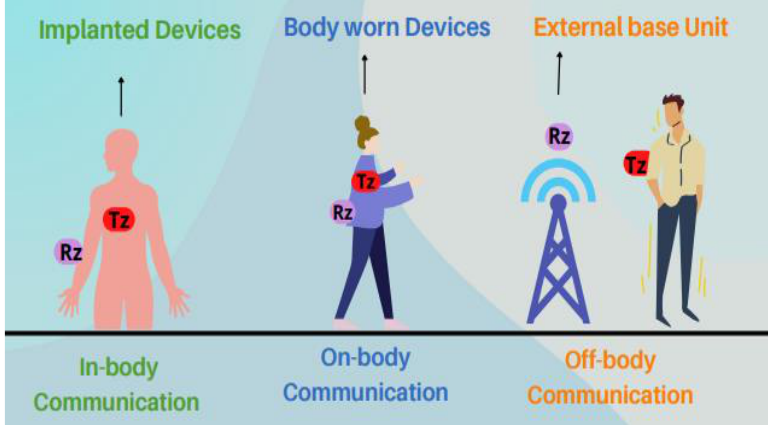
Figure 1. The classification of wireless body-centric communication.